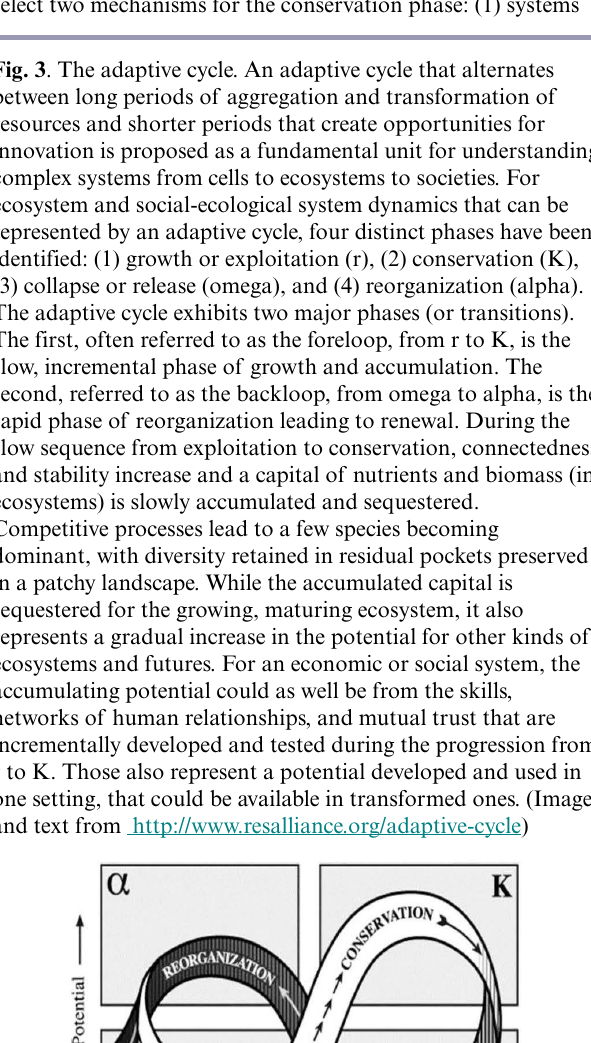
Fig. 3 . The adaptive cycle. An adaptive cycle that alternates between long periods of aggregation and transformation of